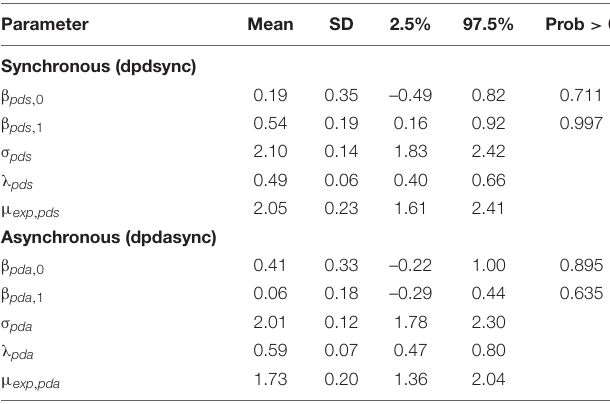
TABLE 2 | Posterior 95% credible intervals for the mean RHI scores for different levels of swash . swash